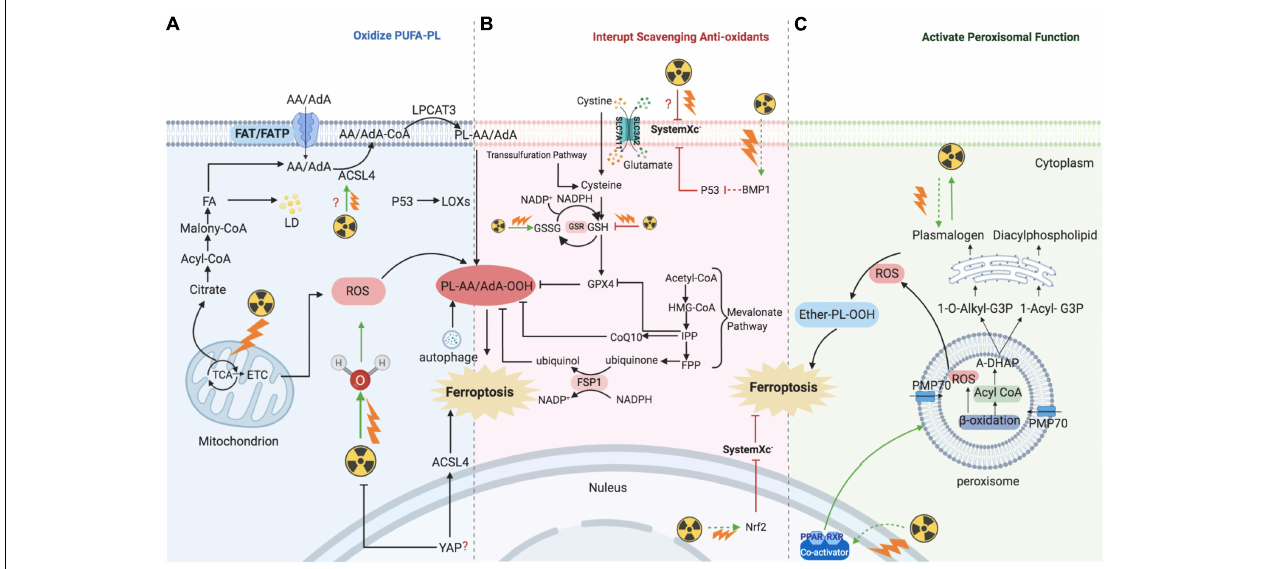
FIGURE 2 | Mechanism of ionizing radiation – regulated ferroptosis. IR introducing excessive lipid peroxidation and decreasing antioxidants levels are key mechanism for regulating ferroptosis. (A) IR induces ferroptosis by introducing excessive lipid peroxidases. IR could up-regulate the level of ACSL4, and then ACSL4 catalyzes AA/AdA to generate Acyl-CoA. After AA generating AA-CoA by ACSL4, LPCAT3 esterifies these derivatives into AA-PL or AdA-PL in plasma membrane or internal membrane. Then, PL-AA/AdA is oxidized into PL-PUFA-OOH under the assistance of LOXs, and ultimately triggers ferroptotic cell death. In addition, IR could also provide amounts of ROS to directly oxidize PL-PUFA via ionizing water molecular or mitochondria. (B) IR induces ferroptosis by interrupting redox homeostasis. IR suppresses the expression of SLC7A11 and inhibits the import of extracellular cystine into cell to synthesis GSH, whereas the level of GSSG is increased. (C) IR induces ferroptosis by activating functions of peroxisome. IR stimulates PPARs which promote the proliferation and fatty acid β -oxidation of peroxisome. Then, peroxisome would synthesize A-DHAP which is transported to endoplasmic reticulum to synthesize plasmalogen. Plasmalogen binds PL, and under the stress of ROS, ether-PL is oxidized to ether-PL-OOH. Once the redox homeostasis is broke, ether-PL-OOH would become an inducer of ferroptotic cell death. IR, ionizing radiation; ACSL, acyl-CoA synthetase long-chain family member; AA, arachidonoyl; AdA, adrenic acid; LPCAT3, lyso-phosphatidylcholine acyltransferase; PL, phospholipid; PUFA, polyunsaturated fatty acids; LOX, lipoxygenase; ROS, reactive oxygen species; GSH, glutathione; GSSG, oxidized GSH; GPX4, glutathione-dependent peroxidase; PPAR, peroxisome proliferator-activated receptors; A-DHAP, acyl-dihydroxyacetone phosphate; FAT; FATP; FA, fatty acid; TCA, tricarboxylic acid cycle; ETC, electron transport chain; LD, lipid droplet; IPP; FPP; CoQ10, ubiquinone; FSP1, NAD(P)H-ferroptosis suppressor protein 1; PMP, peroxisomal membrane